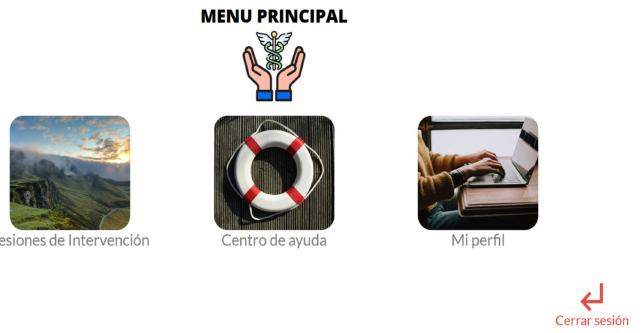
Figure 5. Main menu of the Personal COVID Intervention with the onboarding process indicating to the participant how to use the platform.